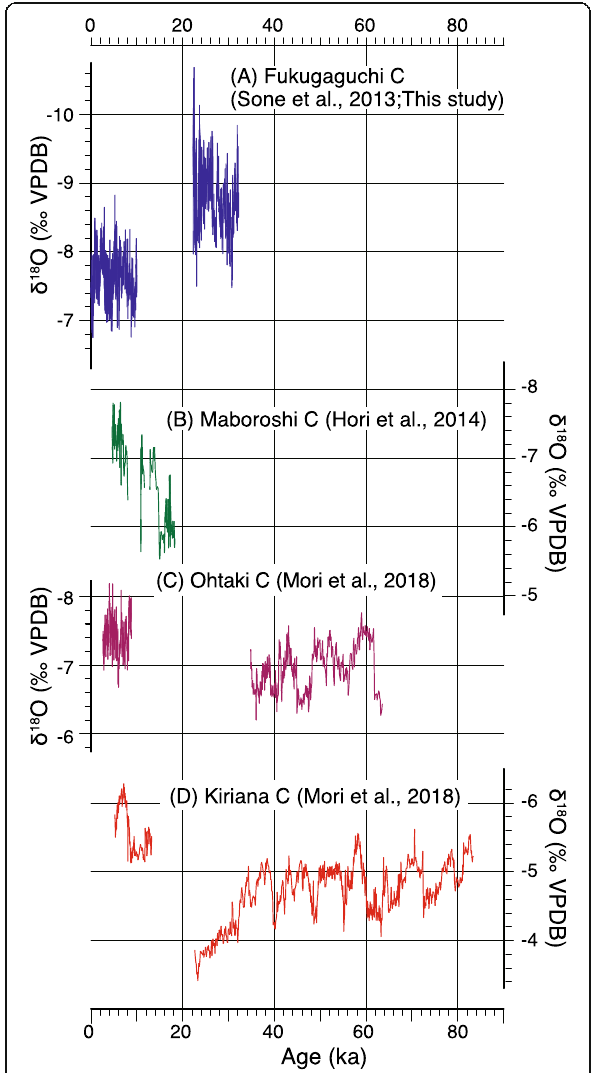
Fig. 7 δ 18 O variability in Japanese caves during the Holocene and last glacial period. a Fukugaguchi Cave in Niigata Prefecture. The Holocene profile is based on FG01 data (Sone et al. 2013). b Maboroshi Cave in Hiroshima Prefecture (Hori et al. 2014; Shen et al. 2010). c Ohtaki Cave in Gifu Prefecture (Mori et al. 2018). d Kiriana Cave in Mie Prefecture (Mori et al.